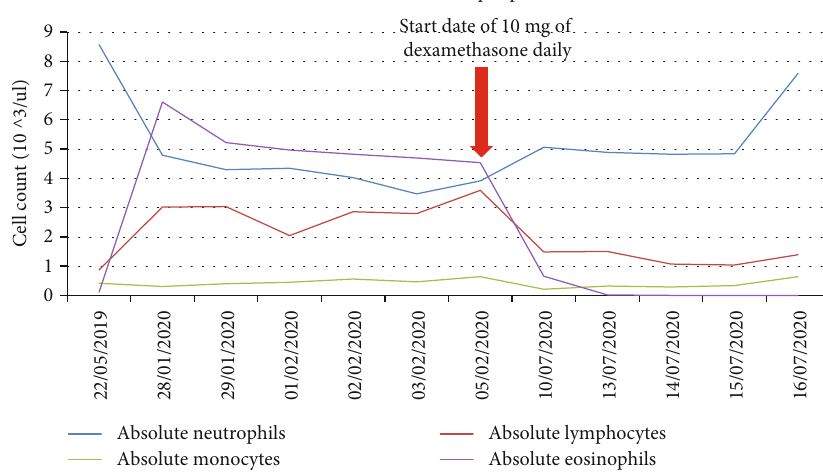
Figure 3: Trend of absolute eosinophil count from 5/22/19 to 7/16/2020 and start date of dexamethasone 10 mg